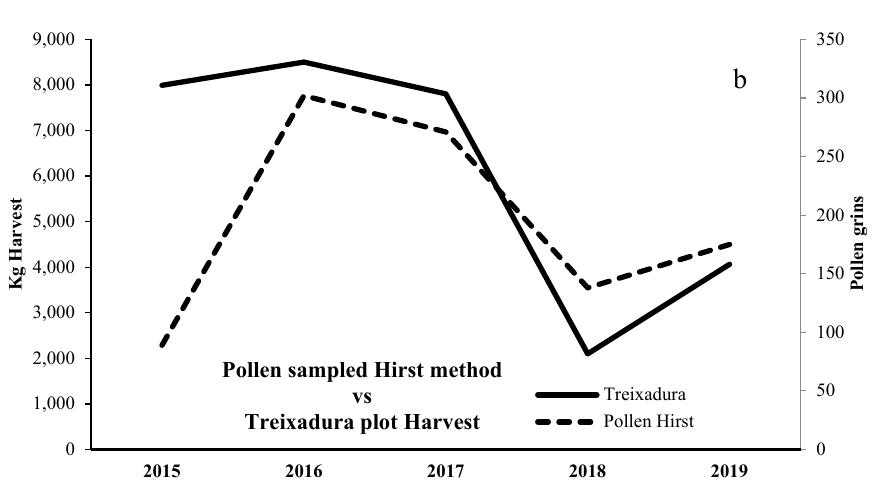
Figure 4. Pollen sampled in the atmosphere of the vineyard by means the Cour method compared with the total annual harvest in the whole Ribeiro D.O. ( a ). Pollen sampled in the atmosphere of the vineyard by means the Hirst method compared with the total harvest of the ‘Treixadura’ plot ( b ). With the aim of analyzing the discordances observed in the seasonal pollen integral (SPIn) between year and traps, a back-trajectory analysis was carried out considering the pollen peak date for each trap and year (Figure 5). Hirst sampler back trajectory analysis showed that in the years with higher pollen concentration (2016 and 2017), the air masses came from inland areas, but in the years with lower pollen concentrations (2015, 2018 and 2019) the air masses came from the ocean. In addition, the Cour sampler back trajectory analysis showed that along the study years the air masses during the pollen peaks came from the north and the ocean.